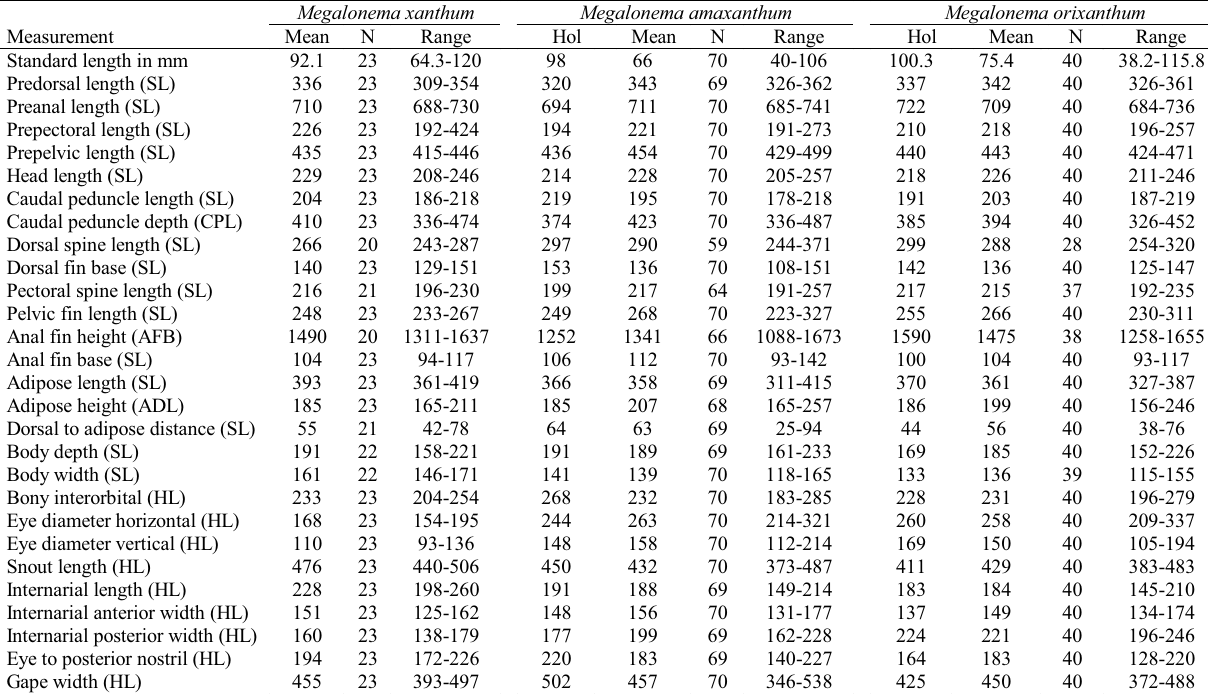
Table 2. Measurement data for Megalonema xanthum , M . amaxanthum , and M . orixanthum ; expressed in thousandths of the standard dimensions given in parentheses. SL=standard length, CPL=caudal-peduncle length, AFB=anal-fin base, ADL=adipose-fin length, HL=head